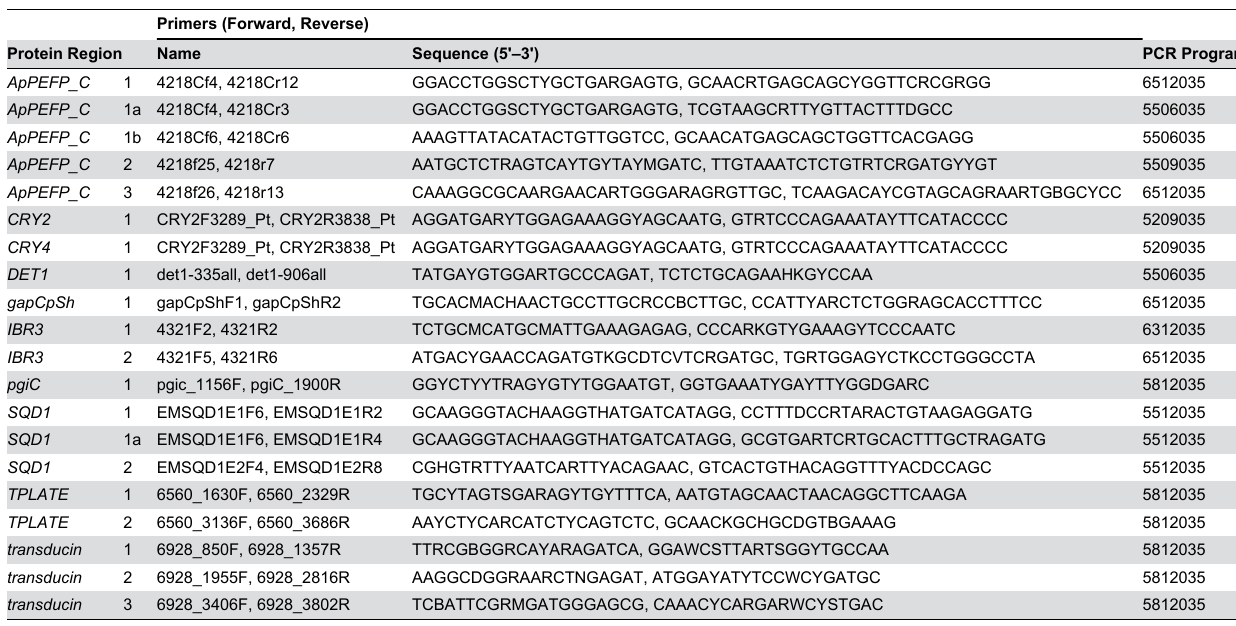
Table 2. Priming details for 20 novel nuclear